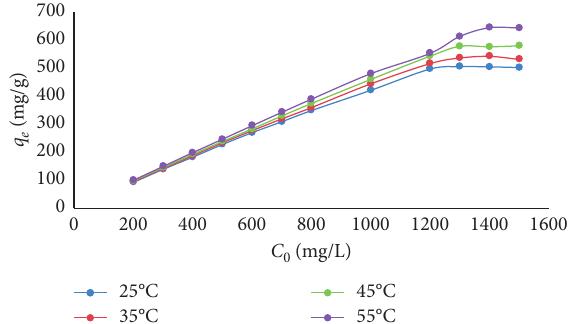
Figure 3: Effect of pH solution on MnO ZCOBLP.